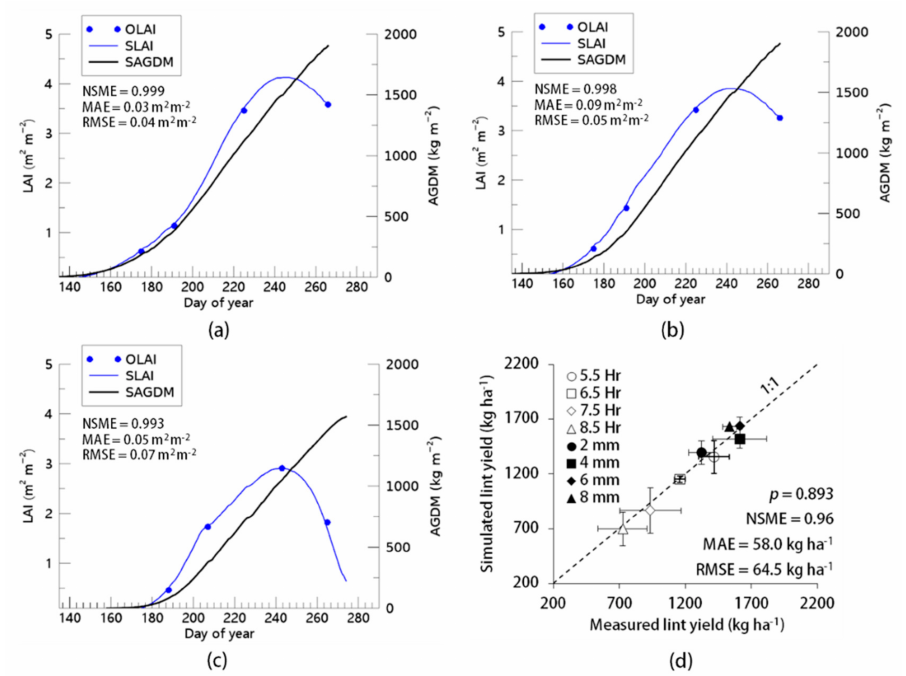
Figure 5. Simulated and observed cotton growth at irrigation intervals of ( a ) 5.5 h and ( b ) 6.5 h in 2003, and ( c ) with 2 mm irrigation in 2005 at the Plant Stress and Water Conservation Laboratory field in Lubbock, Texas, USA ( d ) Comparison between simulated and observed lint yields for all irrigation treatments. OLAI, SLAI, and SAGDM represent observed leaf area index, simulated leaf area index, and simulated above-ground dry mass,